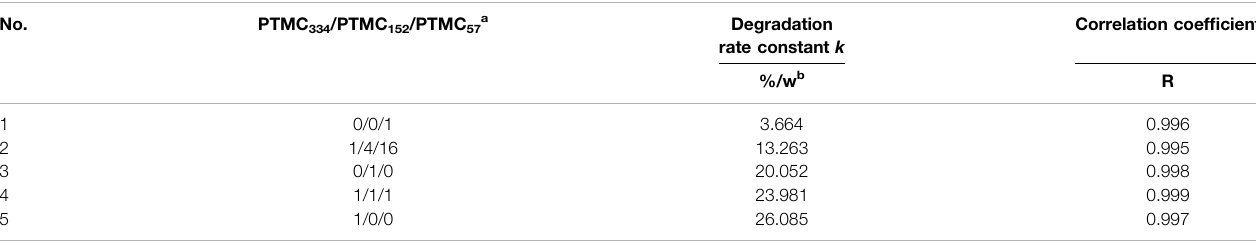
TABLE 3 | The degradation rate constant k of PTMC fi lms and the ternary self-blending fi lms. No.